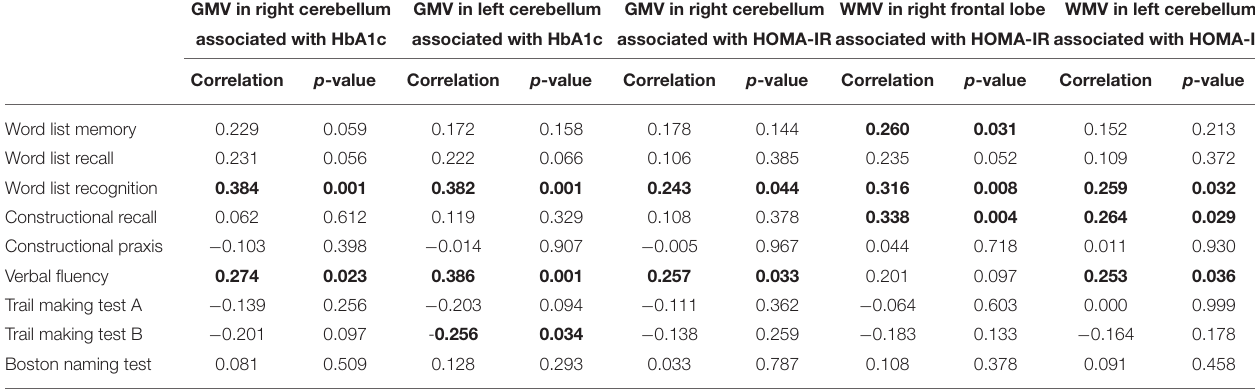
TABLE 2 | Correlations between regional volume changes associated with diabetes biomarkers and cognitive performances.